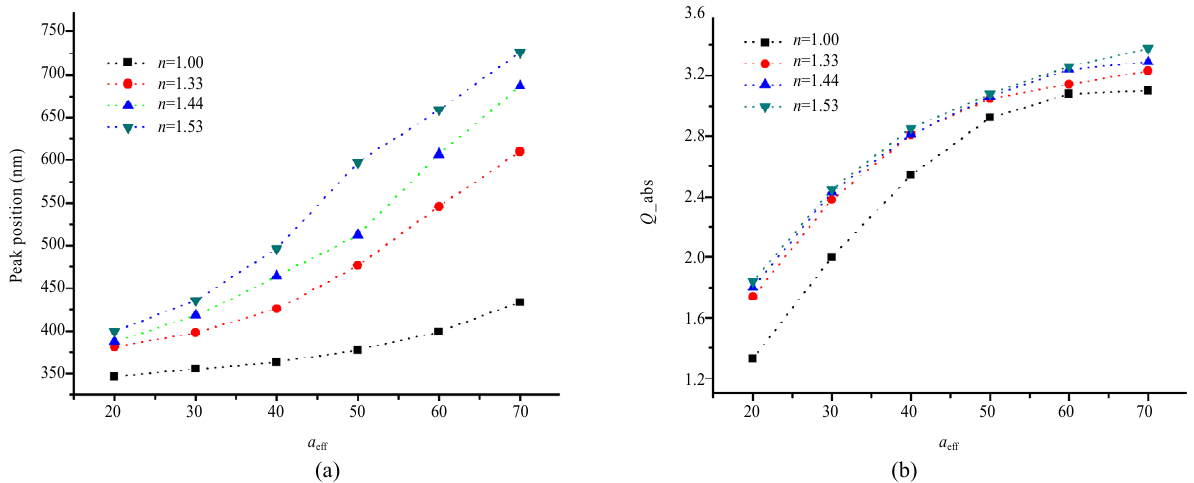
Fig. 7 Variations in (a) LSPR peak wavelength and (b) absorption efficiency of Ag-Fe nanosphere with size.